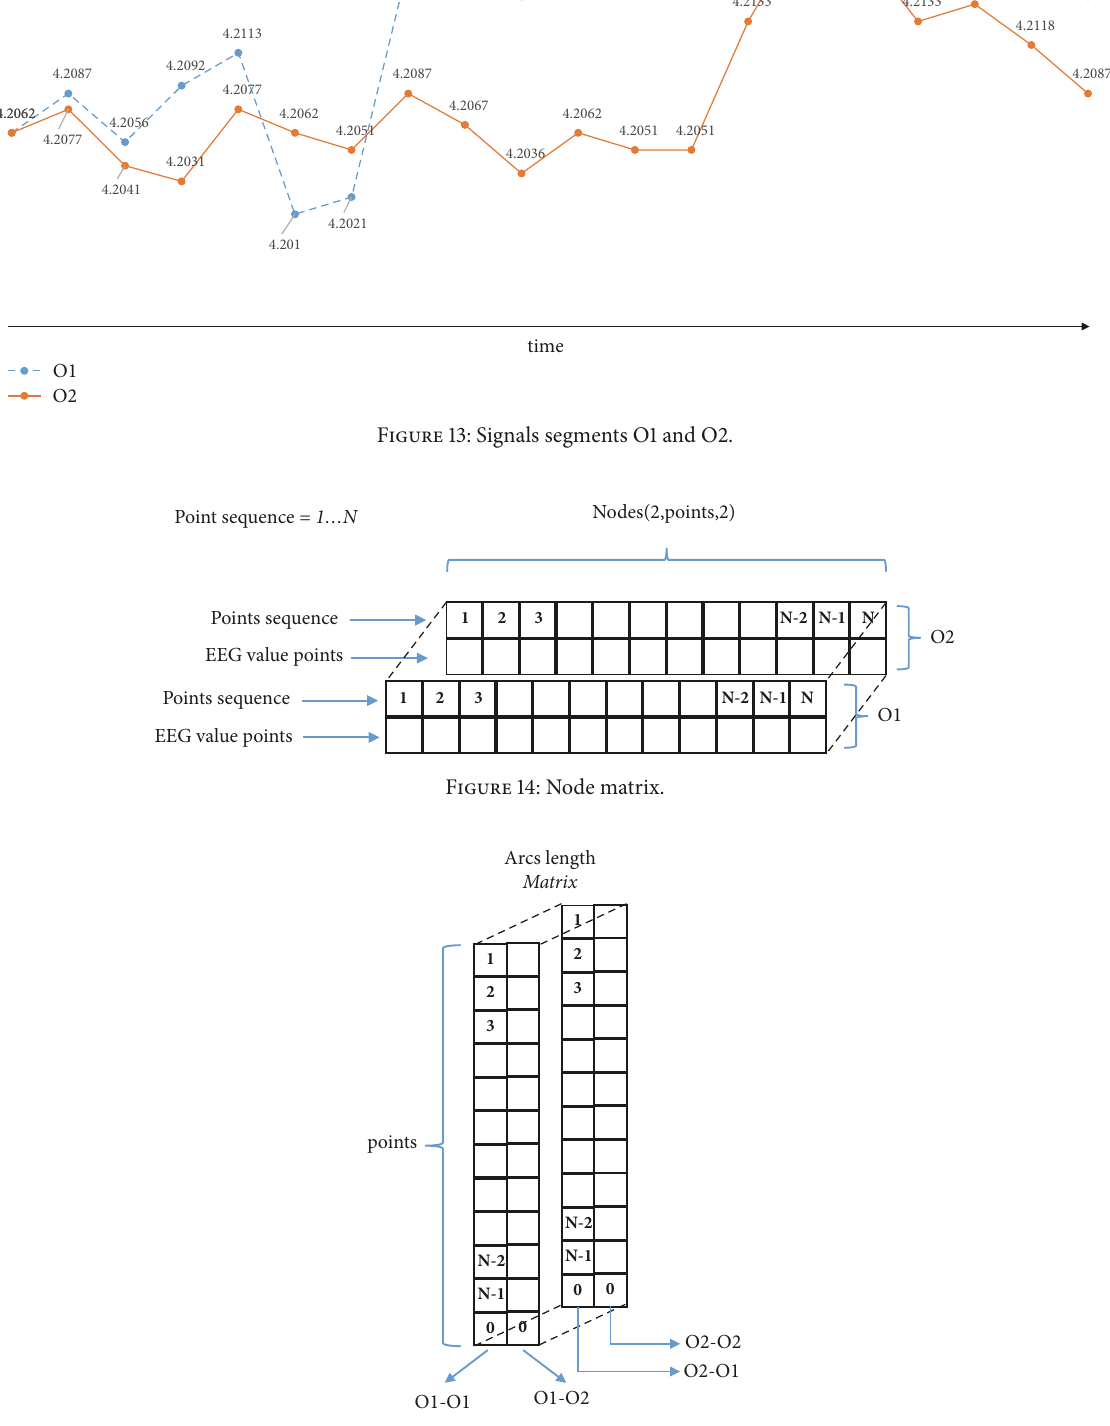
Figure 15: Matrix of distances between cities (𝐴) . Each column stores the distances between the points 𝐶 𝑖 , 𝐶 𝑗 corresponding, where 𝐶 = { O 1, O 2}